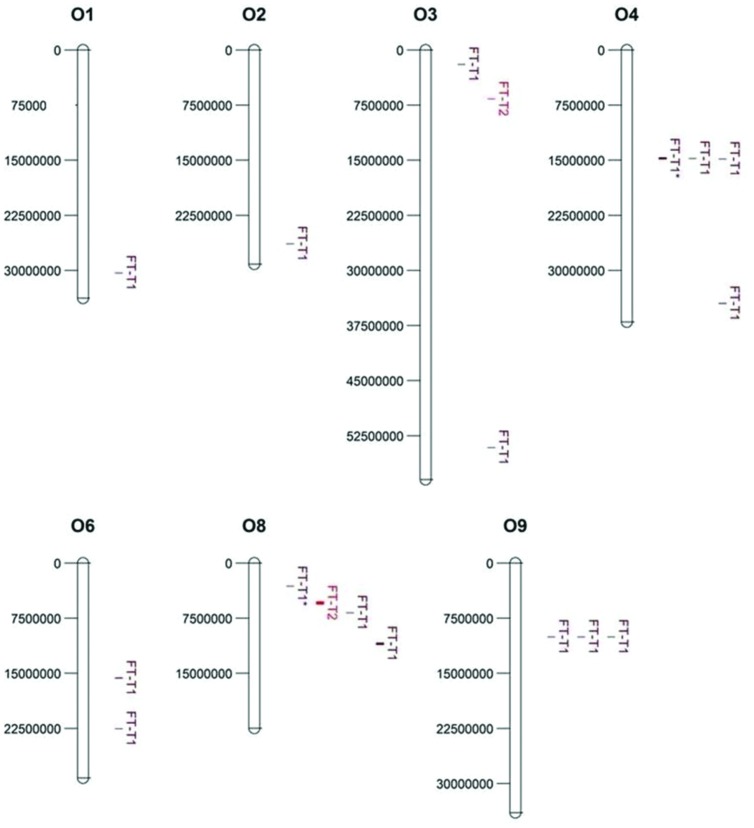
Physical map and chromosomal position of significant QTL (P < 0.01) associated with temperature-related curd induction in cauliflower under natural temperature regime (GH-T1) and under high ambient temperatures of 22.5°C (GH-T2), denoted as FT-T1 (dark red) and FT-T2 (red), respectively. Significant QTL are located on chromosomes O1, O2, O3, O4, O6, O8, and O9 (left: physical position in bp). Two significant FT-T1 QTL on O4 and O8, marked with an asterisk (FT-T1∗), were genetically linked (r2 = 0.7).